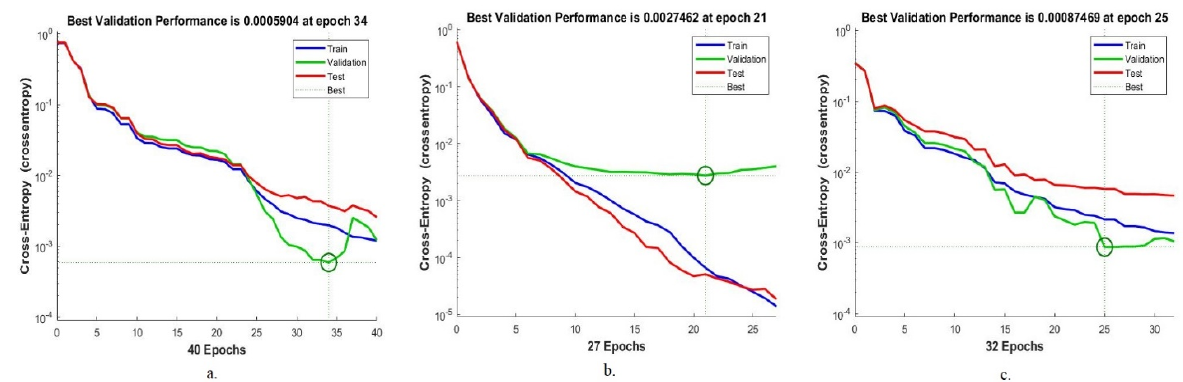
Figure 15. Best performance of ANN on hemorrhage dataset based on hybrid features by ( a ) GoogLeNet and GLCM + LBP, ( b ) ResNet-50 and GLCM + LBP and ( c ) AlexNet and GLCM + LBP.